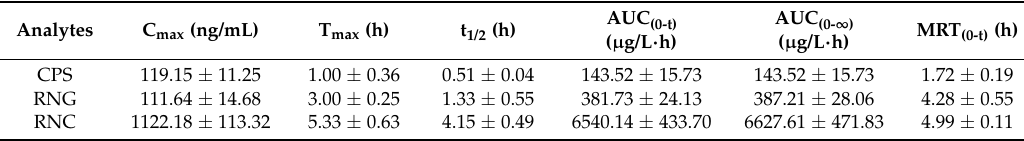
Figure 5. Time-concentration curves of CPS, RNG, and RNC in plasma from rats after oral administration of complanatuside. CPS: complanatuside; RNG: rhamnocitrin 3- O - β -glc; RNC: rhamnocitrin. Table 6. The pharmacokinetic parameters of CPS, RNG, and RNC in rats after oral administration of complanatuside ( X ± S , n =